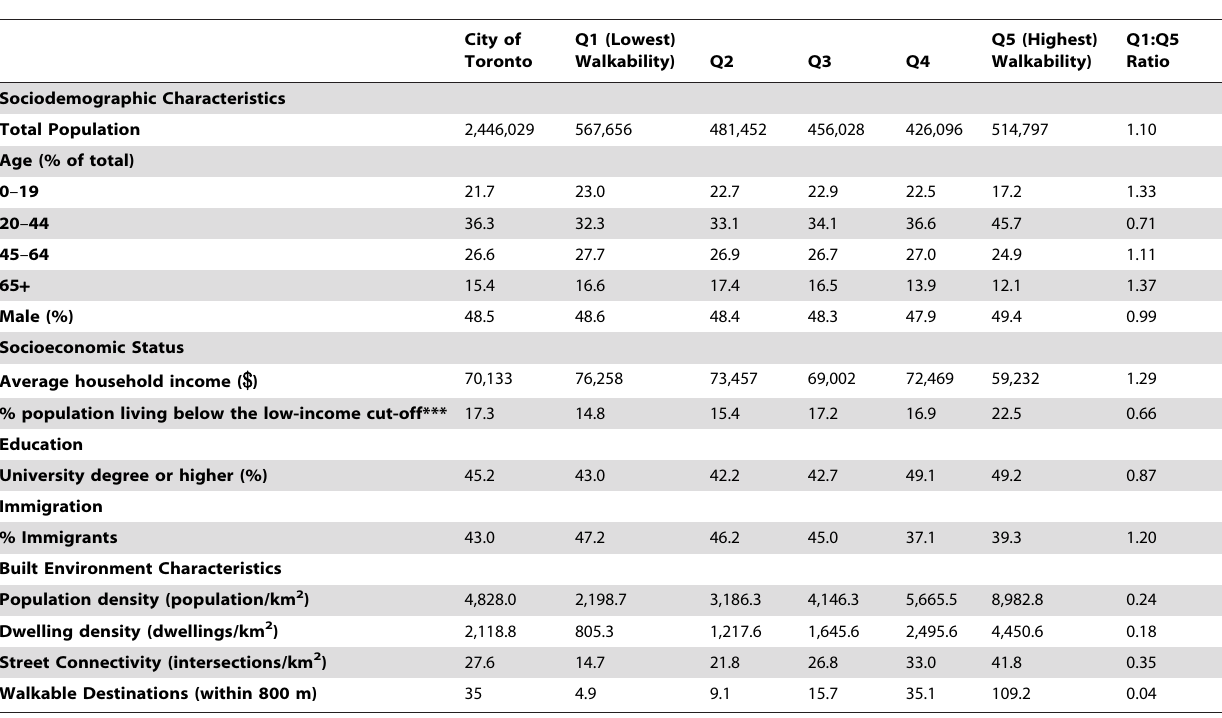
Table 1. Sociodemographic* and Built Environment Characteristics by Walkability Index